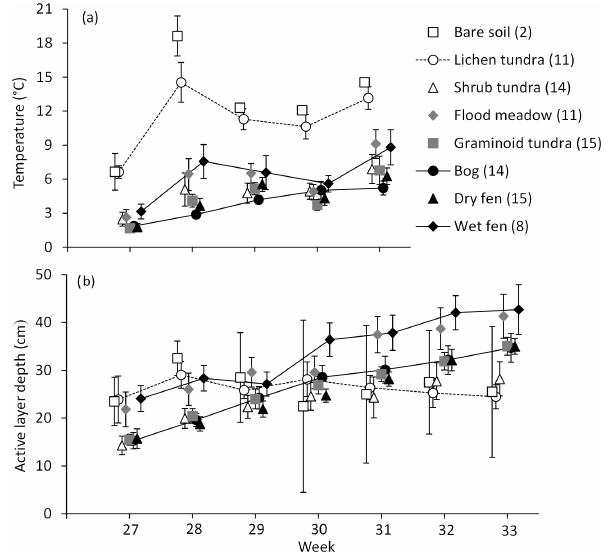
Figure 5. Development of (a) soil temperature (at a depth of 15cm) and (b) depth of the active, unfrozen soil layer (mean ± 85% CI) during the growing season (week 27 represents early July with 160 DD, week 31 early August with 380 DD and week 33 mid- August with 550 DD) in the land cover types of Tiksi tundra. The number of replicate plots is given in brackets, and for the sake of clarity, land cover types are deviated from each other within weeks and only some have means connected with